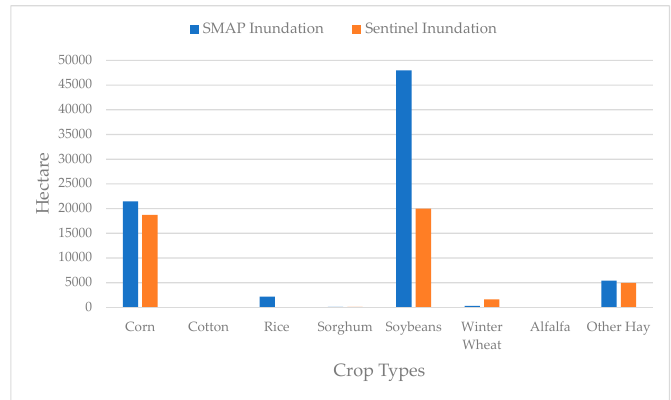
Figure 9 . Comparison of SMAP and Sentinel-1 derived inundation acreage of the Missouri Flood (May 2017) over major crop types